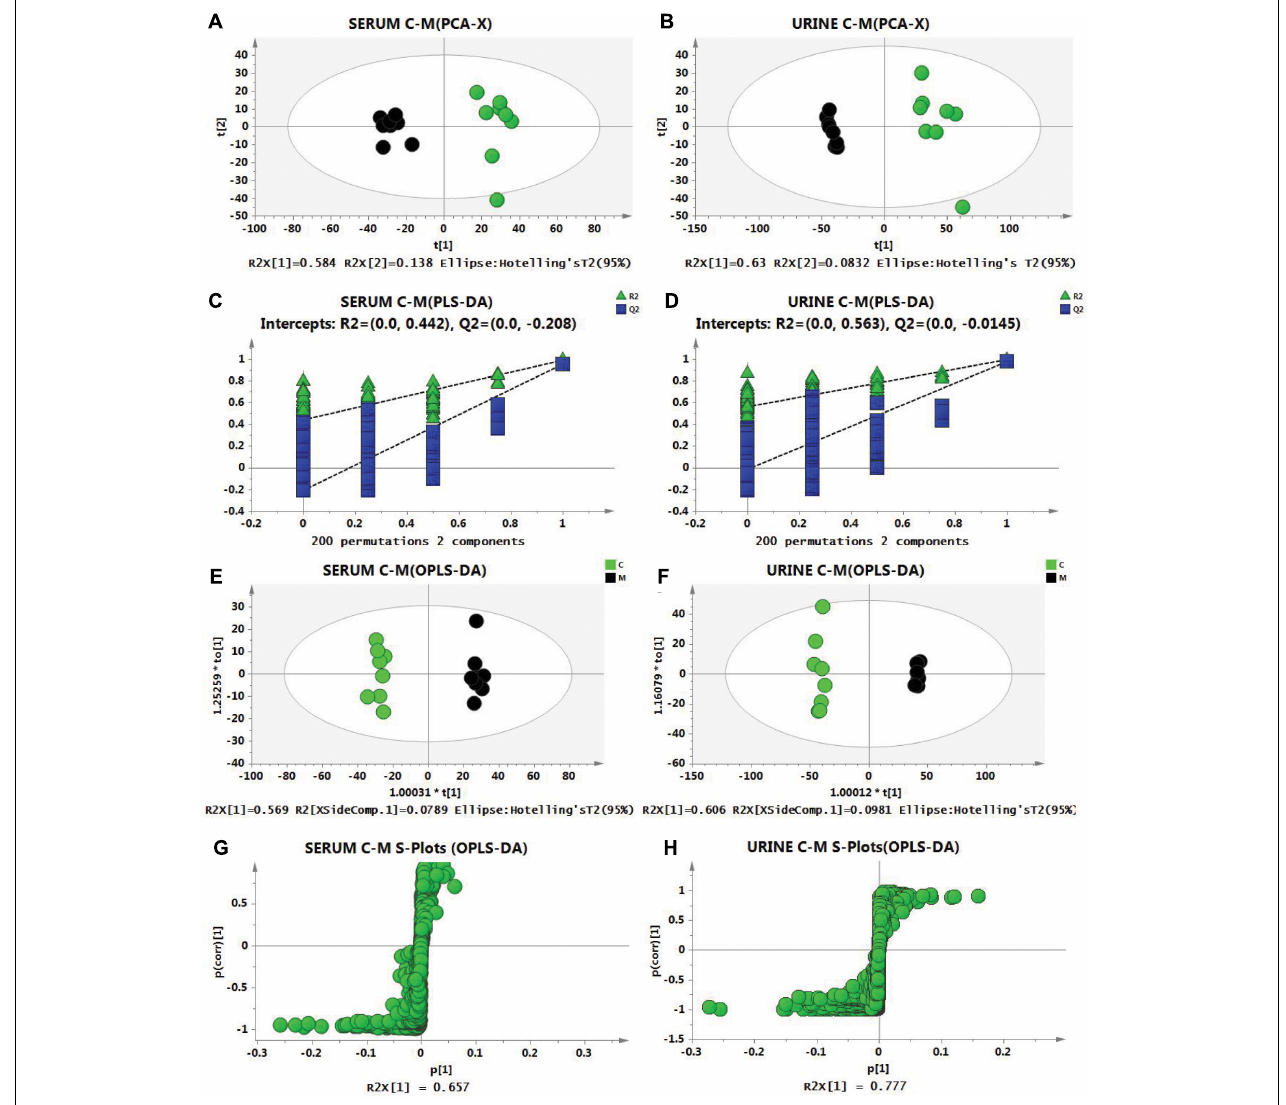
FIGURE 3 | Score plots from the PCA model of the control group (green) vs. the model group (black) for (A) serum and (B) urine. Two hundred permutations of the PLS-DA model for serum (C) and urine (D) . R 2 (green triangle); Q 2 (blue square). Score plots form the OPLS-DA model of the control group (C, green) vs. the model group (M, black) for serum (E) and urine (F) . S-Plots from the OPLS-DA model for serum (G) and urine (H)